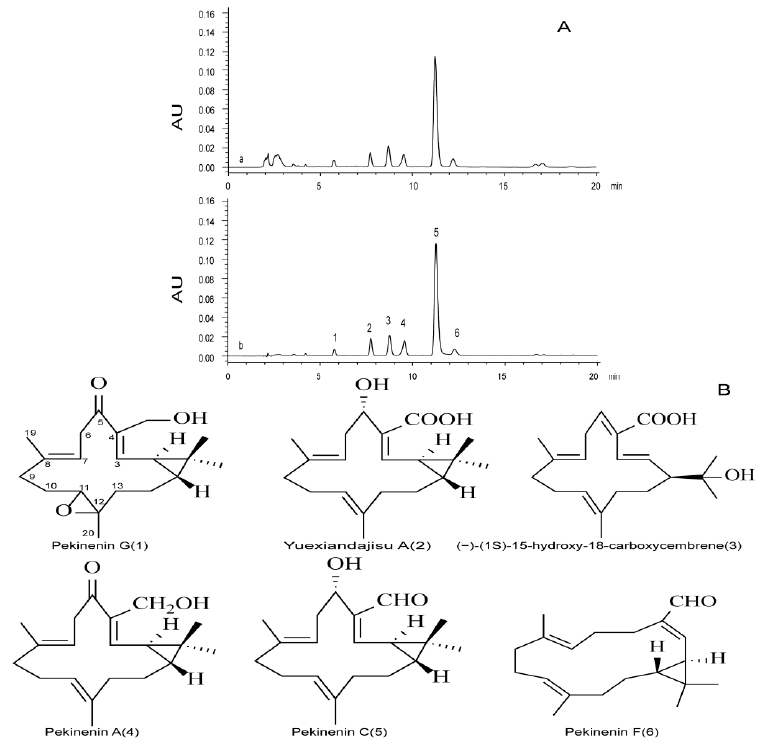
Figure 1. HPLC chromatogram of TDEP ( A ): (a) TDEP, (b) standards; Structure of identified components of TDEP ( B ): six peaks were identified by comparing with the standard substance: Pekinenin G ( 1 ), Yuexiandajisu A ( 2 ), ( − )-(1S)-15-hydroxy-18-carboxycembrene ( 3 ), Pekinenin A ( 4 ), Pekinenin C ( 5 ), Pekinenin F ( 6 ).